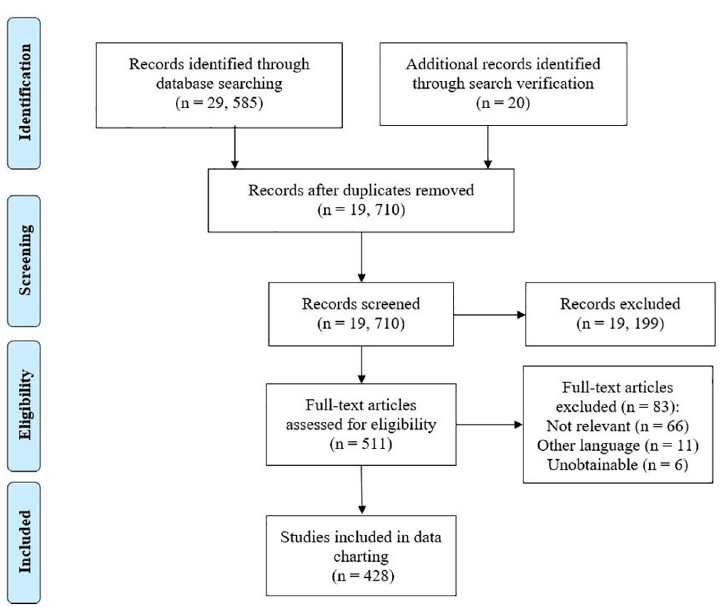
Fig 1. PRISMA diagram. PRISMA diagram depicting the flow of captured publications through the eligibility and inclusion process.